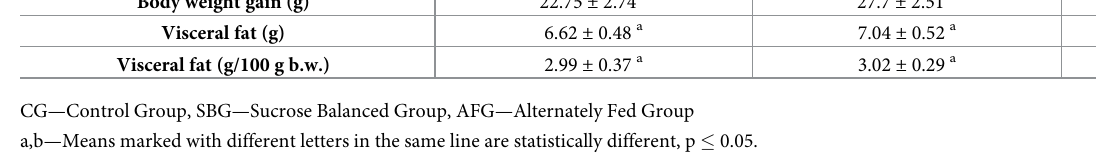
Table 6. Effect of sucrose content diet and alternating feeding on body weight gain and visceral fat in the examined rats. Traits